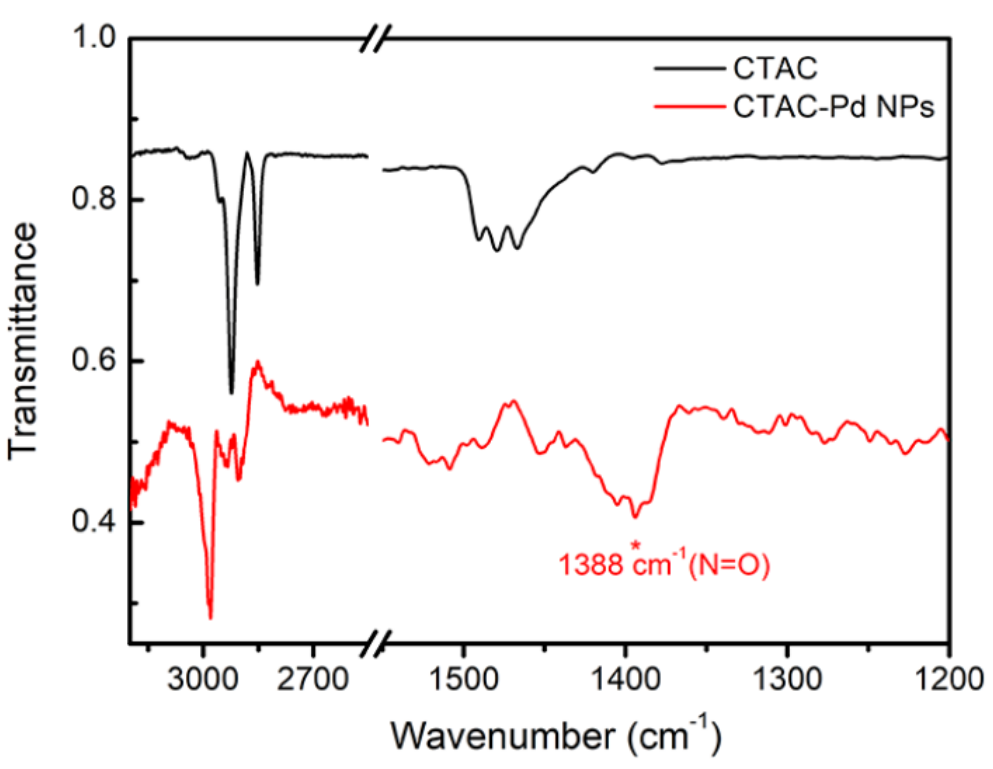
Figure 1. FT-IR spectra of CTAC and the CTAC-Pd NPs.